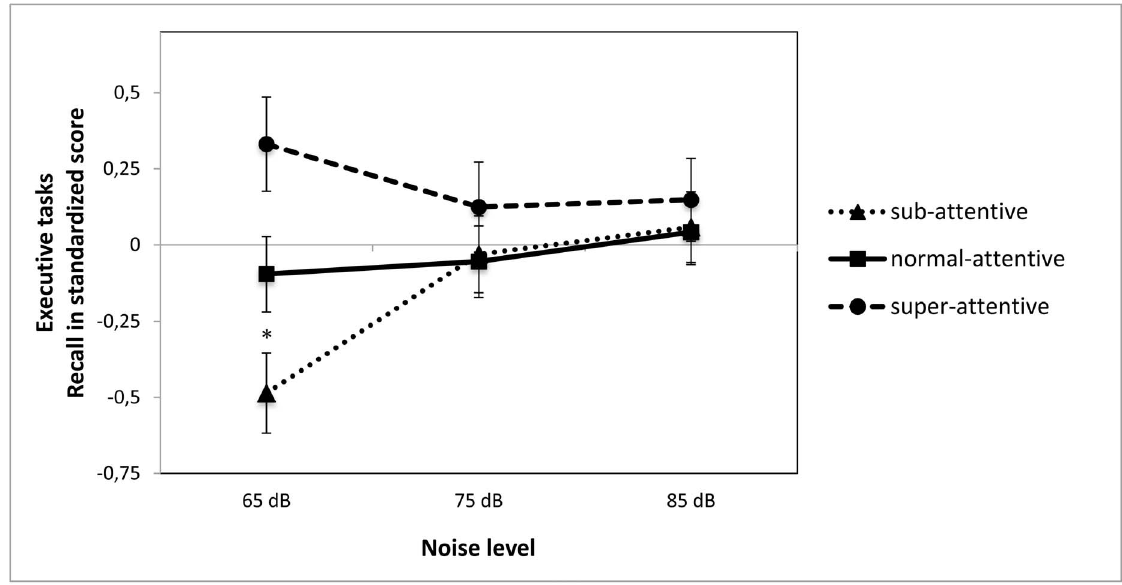
Figure 2. Performance on non-executive function tasks as a function of attention ability and noise level. Note: White noise levels were 65, 70, 75 dB, speech level < 75 dB; * indicates a significant difference between groups in the 65 dB condition ( F (2,86)=8.18, p =.001).